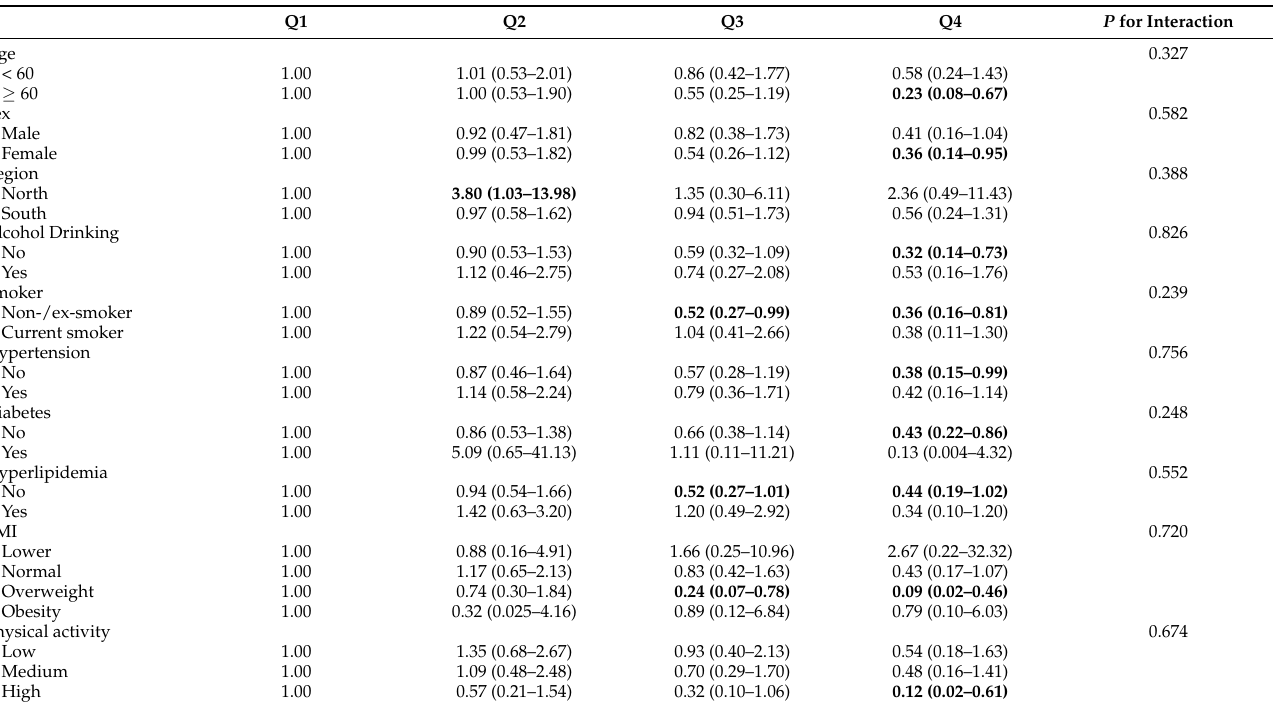
Table 3. Subgroup analyses of the association between selenium intake (quartile) and prevalent